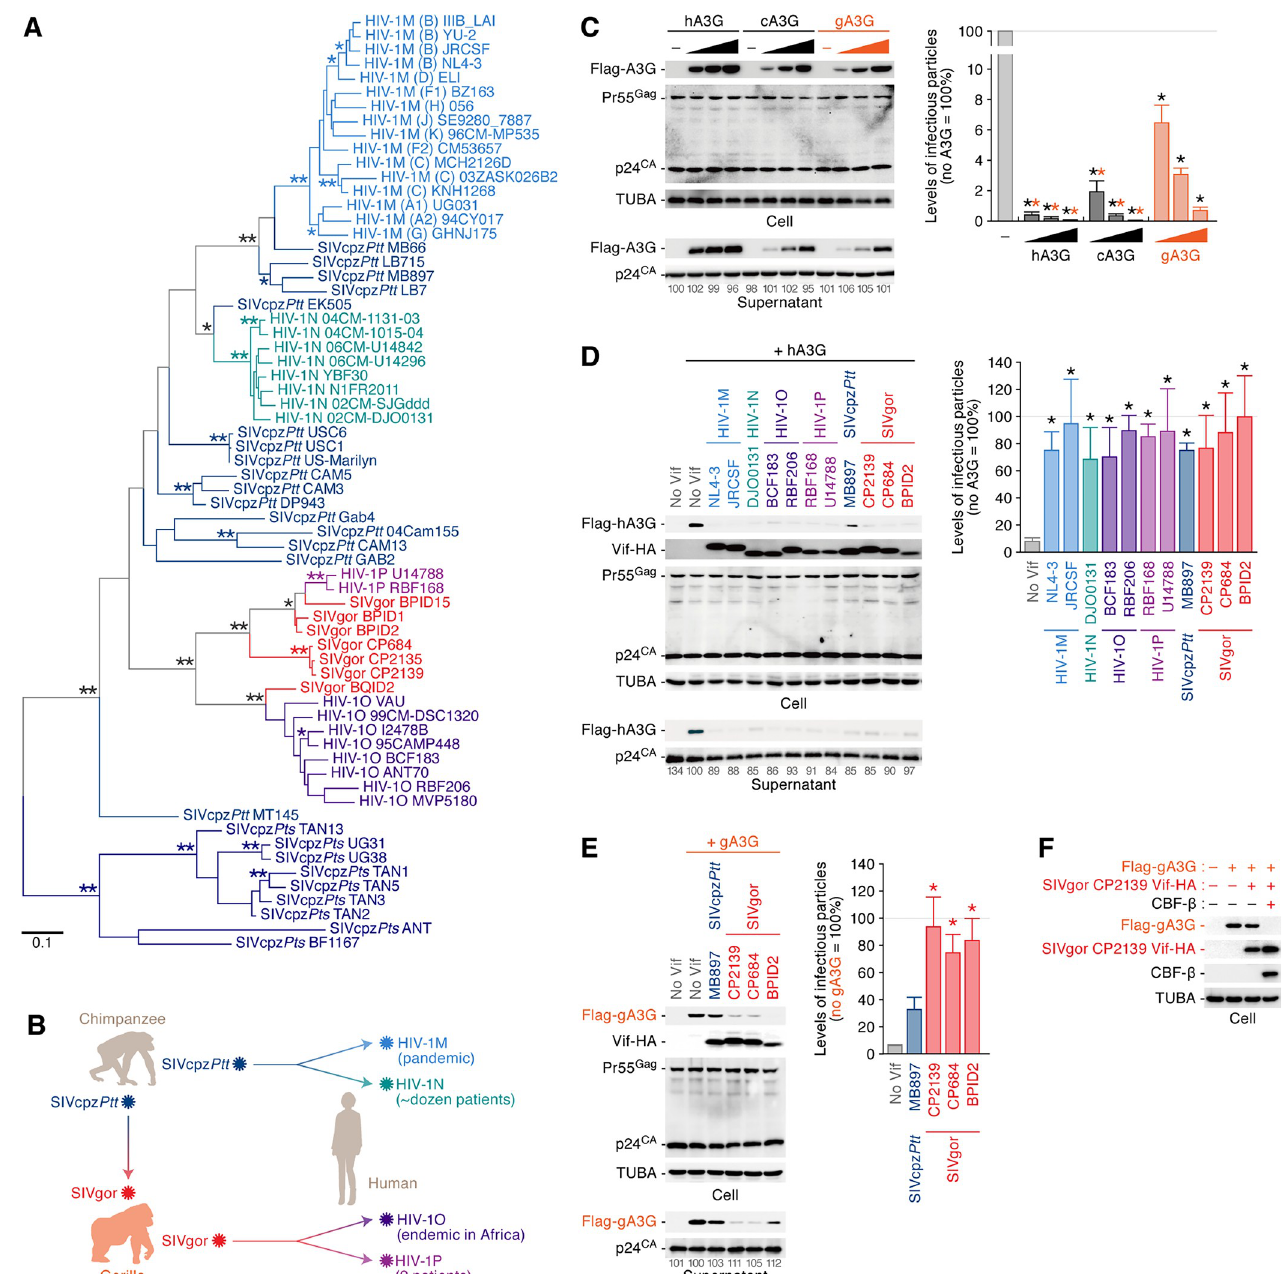
Fig 1. Failure of neutralizing antiviral effect of gA3G by SIVcpz Ptt Vif. (A) A phylogenetic tree of the vif gene of great ape lentiviruses. The vif sequences were extracted from Los Alamos HIV sequence database (https://www.hiv.lanl.gov/components/sequence/HIV/search/search.html) and the phylogenetic tree was constructed as described in Materials and Methods. The bootstrap values are indicated as follows: � , > 80%; �� , > 95%. A scale bar indicates 0.1 nucleotide substitutions per site. (B) A scheme of cross-species lentiviral transmission in great apes. (C) Antiviral activity of great ape A3G. HEK293T cells were co- transfected with pNL4-3 Δ vif (500 ng) and the different amounts of expression plasmids for great ape A3G (0, 50, 100, and 200 ng; the plasmid amount was normalized by empty vector). Cells and supernatants were harvested at two days post-transfection and were used for Western blotting (left) and TZM-bl assay (right). For Western blotting, the band intensity of viral p24 was quantified and the intensity value of the leftmost lane was set to 100%. For TZM-bl assay, the infectivity value without A3G was set to 100%. (D and E) Counteracting ability of great ape lentiviral Vif against great ape A3G. HEK293T cells were co- transfected with pNL4-3 Δ vif (500 ng) and the expression plasmids for hA3G (D; 10 ng) or gA3G (E; 50 ng) and the Vif of indicated viral strain (500 ng). In C-E, cells and supernatants were harvested at two days post-transfection and were used for Western blotting (left) and TZM-bl assay (right). For Western blotting, the band intensity of viral p24 was quantified and the intensity value of the A3G expressing cells without Vif (second from the left) was set to 100%. For TZM-bl assay, the percentage of the value without A3G are shown. The mean values of three independent experiments ± SEM are shown, and statistically significant